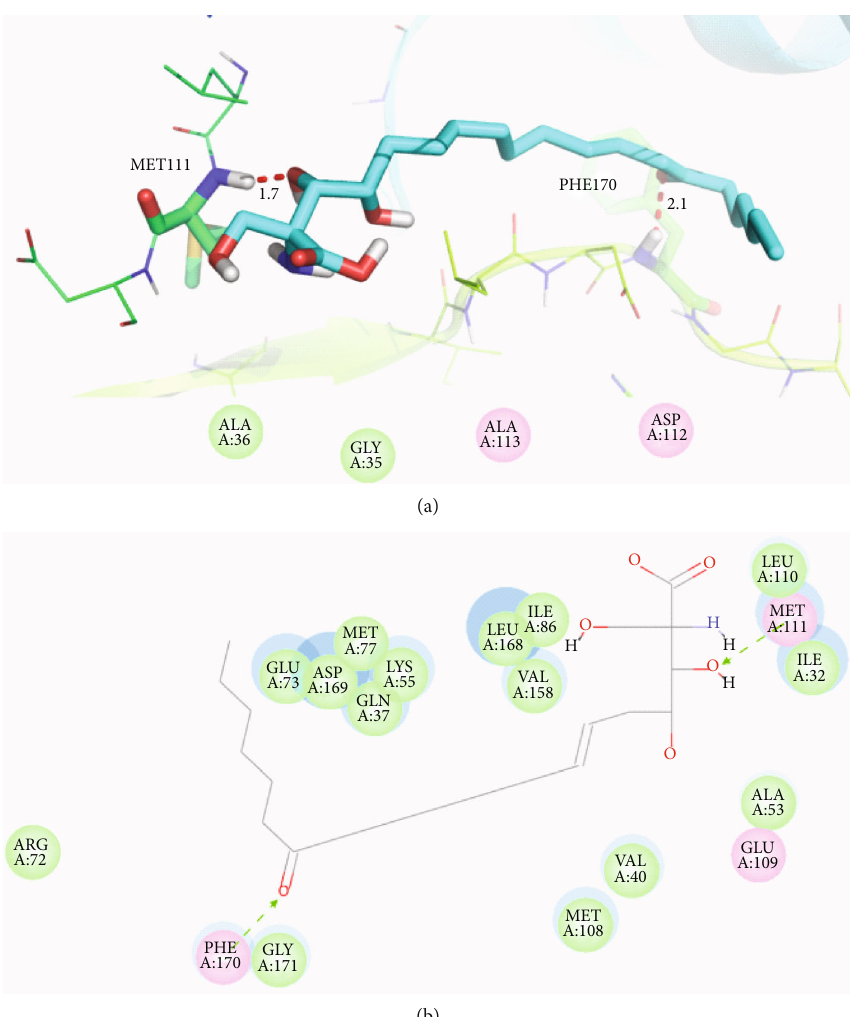
Figure 7: (a) Proposed binding mode of myriocin with MAPK8 (PDB code: 4G1W). (b) 2D presentation of interaction between myriocin and